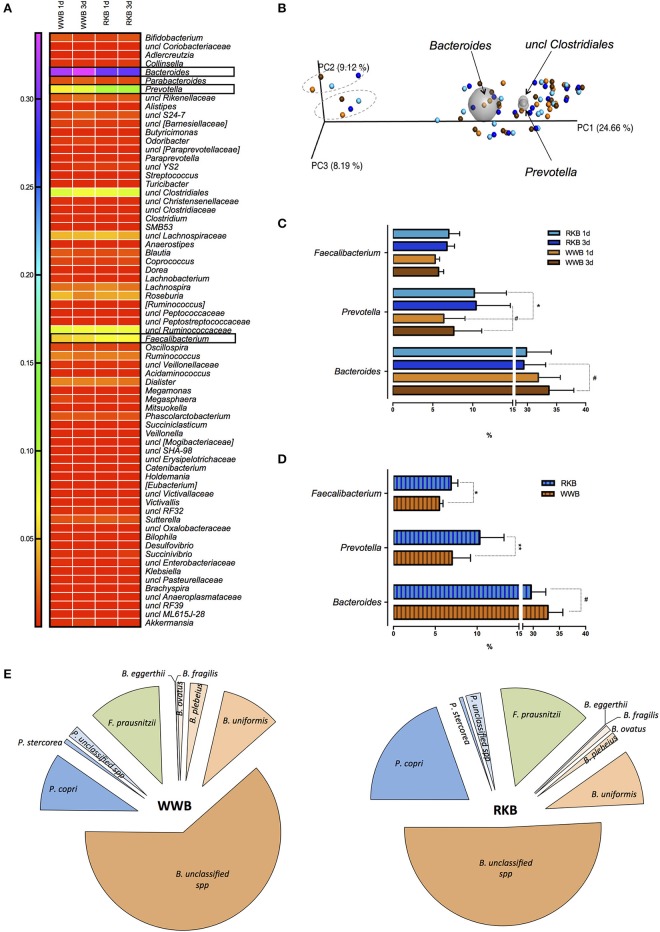
The OTUs assignment to the genus level presented as a heat map per each test occasion after WWB and RKB product consumption during 1 or 3d period (A); PCoA plot showing distribution of bacterial community between the participants after consumption of RKB 1d (light blue circles), RKB 3d (blue circles), WWB 1d (orange circles) and WWB 3d (brown circles), while bi-plots (grey spheres) visualize the three taxa driving the differences in the cohort where outlier two persons are circled with dashed line (B); The most significant differences in bacterial genera between bread consumption for each test occasions included duration of the bread consumption (C) where RKB 1d (n = 18), WWB 1d (n = 18), RKB 3d (n = 19), WWB 3d (n = 19), and pooled result (D) from each type of bread (RKB vs. WWB, n = 37/per each bread) on genus level or (E) species level. *p < 0.05, **p < 0.01, #p ≤ 0.08; RKB, rye kernel bread; WWB, white wheat bread; B., Bacteroides; P., Prevotella; F., Faecalibacterium; spp., species.